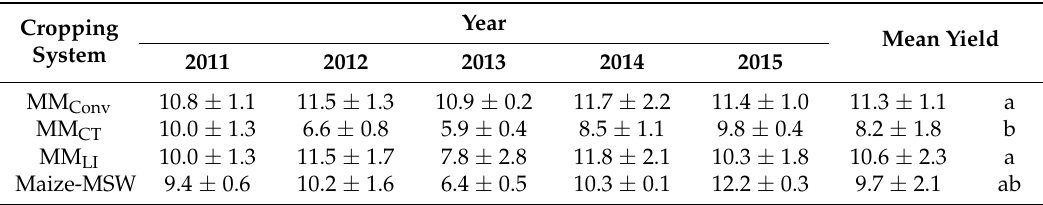
Table 4. Mean maize grain yield (mean ± standard deviation, at 15% moisture content, t ha − 1 ) of the cropping systems (MM Conv : conventional maize monoculture; MM CT : conservation tillage maize monoculture; MM LI : low-input maize monoculture; Maize-MSW: integrated maize rotation). For each cropping system, mean values followed by the same letter (“a” and/or “b”) are not different according to Tukey’s HSD test ( p < 0.05).